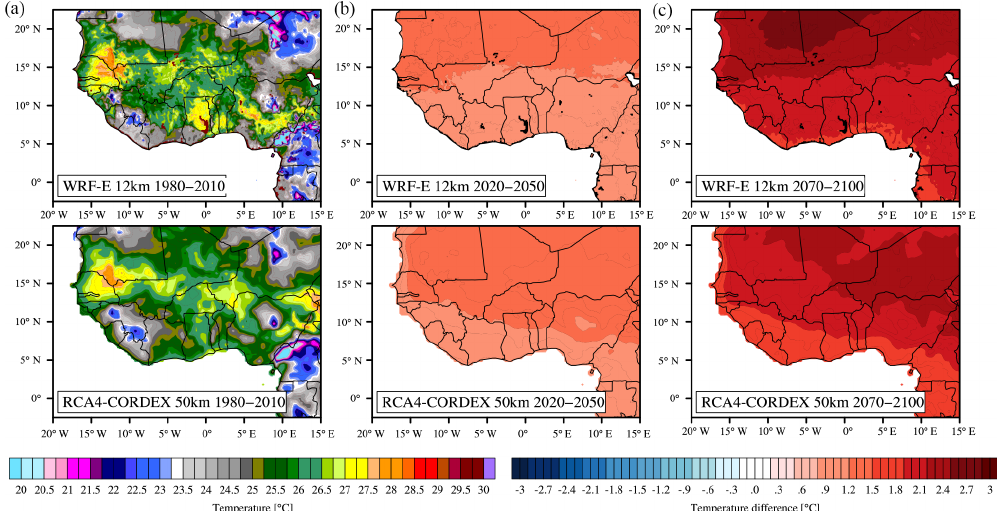
Figure 7. Near-surface temperature averaged over the historical reference period 1980–2010 (a) and climate change signal for the near future 2020–2050 (b) and the end of the 21st century 2070–2100 (c) for the WRF multi-model ensemble WRF-E and a two-member ensemble